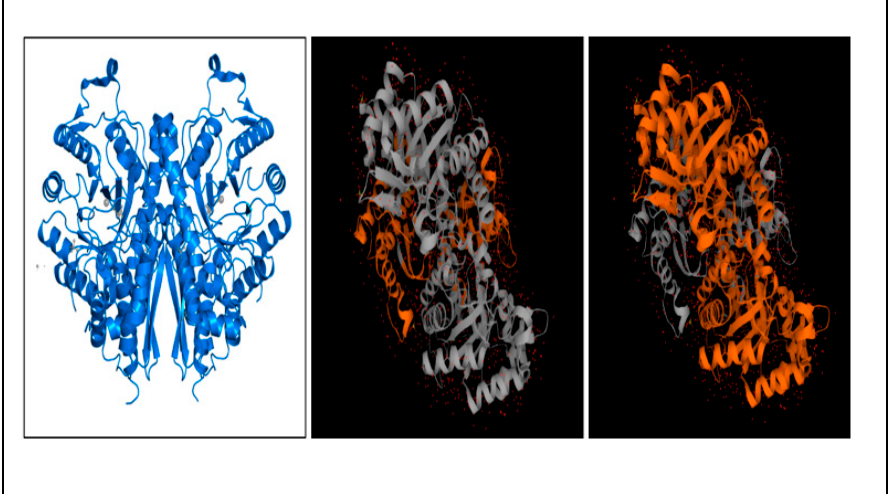
Figure 7. Figure showing two copies of enolase 1, N-terminal domain and C-terminal domain, re- spectively [89,91–95] (https://www.ebi.ac.uk/pdbe/entry/pdb/3qtp/analysis, accessed on 25 October 2022).